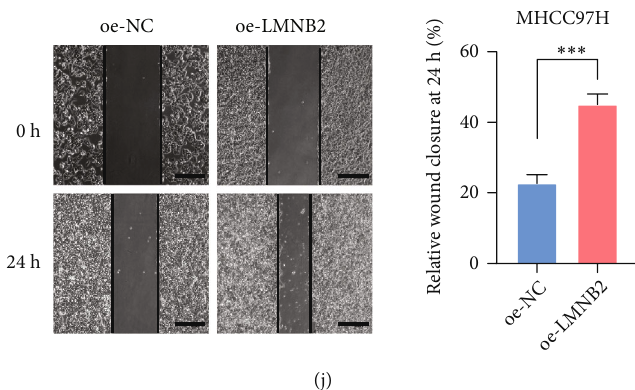
Figure 4: Functional validation of LMNB1 and LMNB2 in HCC. (a) The protein expression levels of LMNB1 and LMNB2 in normal liver cells and four HCC cell lines. (b) Western blotting analyses for overexpression e ffi cacy detection in Huh7 and MHCC97H cells after transfection with LMNB1 and LMNB2 plasmids. (c, d) CCK-8 assays of Huh7 and MHCC97H cells with LMNB1 and LMNB2 overexpression, respectively. (e, f) Colony formation assays of Huh7 and MHCC97H cells with LMNB1 and LMNB2 overexpression, respectively; scalebar = 5mm . (g, h) Transwell invasion assays of Huh7 and MHCC97H cells with LMNB1 and LMNB2 overexpression, respectively; scale bar = 100 μ m . (i, j) Cell scratch assays of Huh7 and MHCC97H cells with LMNB1 and LMNB2 overexpression, respectively; scale bar = 500 μ m . Data are presented as the mean ± SD . Statistical di ff erences between two groups were evaluated using Student ’ s t -test, ∗ P < 0 : 05 , ∗∗ P < 0 : 01 , and ∗∗∗ P < 0 : 001